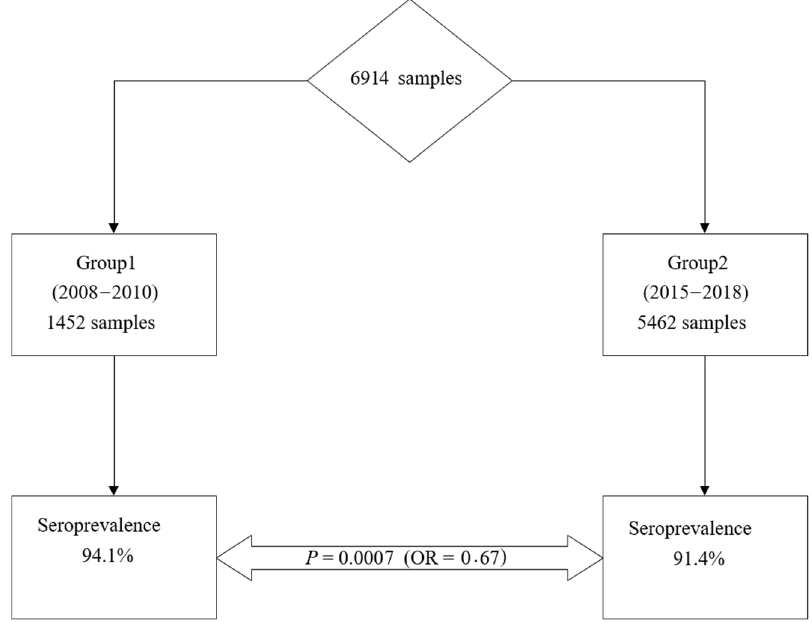
Figure 2. Evolution of rubella seroprevalence among fertile women.